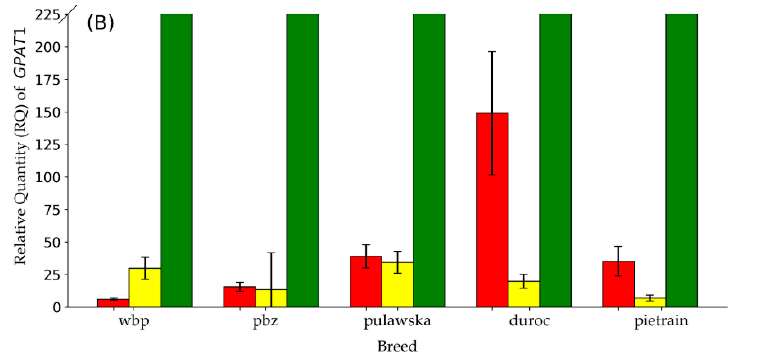
Figure 2. Relative quantity (RQ) of GPAT1 transcript abundance in m. longissimus lumborum, subcutaneous fat, liver tissue across all pigs within each breed (* p ≤ 0.05; ** p ≤ 0.01). Data are presented as means ± SEM. ( A ) Full chart; ( B ) zoomed in chart with y-axis ranging from 0 to 225.